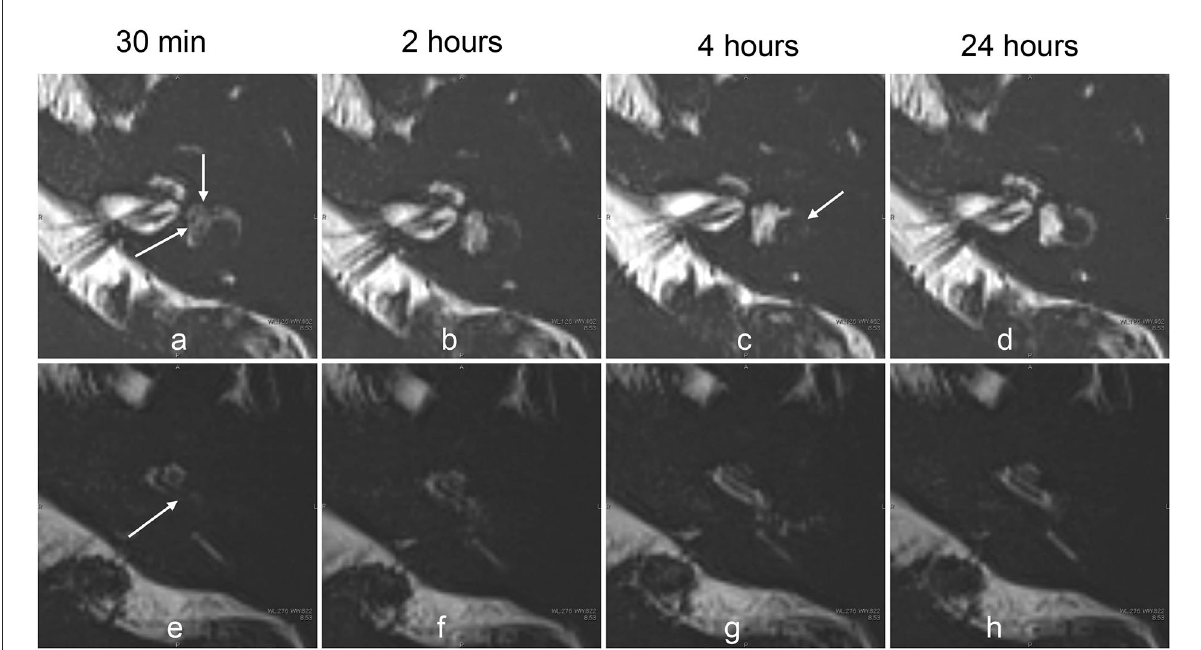
FIGURE8 Serial MR cisternography (TE: 3,200ms) of the left ear in a 33-year-old female volunteer at 30min, and 2, 4, and 24h after the intratympanic administration of 17 O-labeled saline (a–c) . The MR scan was initiated ∼ 30min after the intratympanic administration of 17 O-labeled saline into the left middle ear. The upper row (a–d) shows the images at the level of the cochlear nerve. The lower row (e–h) shows the images at the level of the cochlear aqueduct. The signal decreases in the vestibule (arrows, a ) and in the basal turn of the cochlea (arrows, e ) were most prominent in the image obtained at 30min. The extent of the signal decrease in the vestibule in this volunteer is less than that for the volunteer whose images are shown in Figure 4. At 2h, the vestibular signal and the signal in the basal turn of the cochlea began to recover (b,f) . At 4h, the signal for the lateral semicircular canal decreased (arrows, c ), and the signal for the cochlear basal turn recovered (g) . At 24h (d,h) , the signal for the left labyrinthine fluid recovered to the level seen in the contralateral side (not